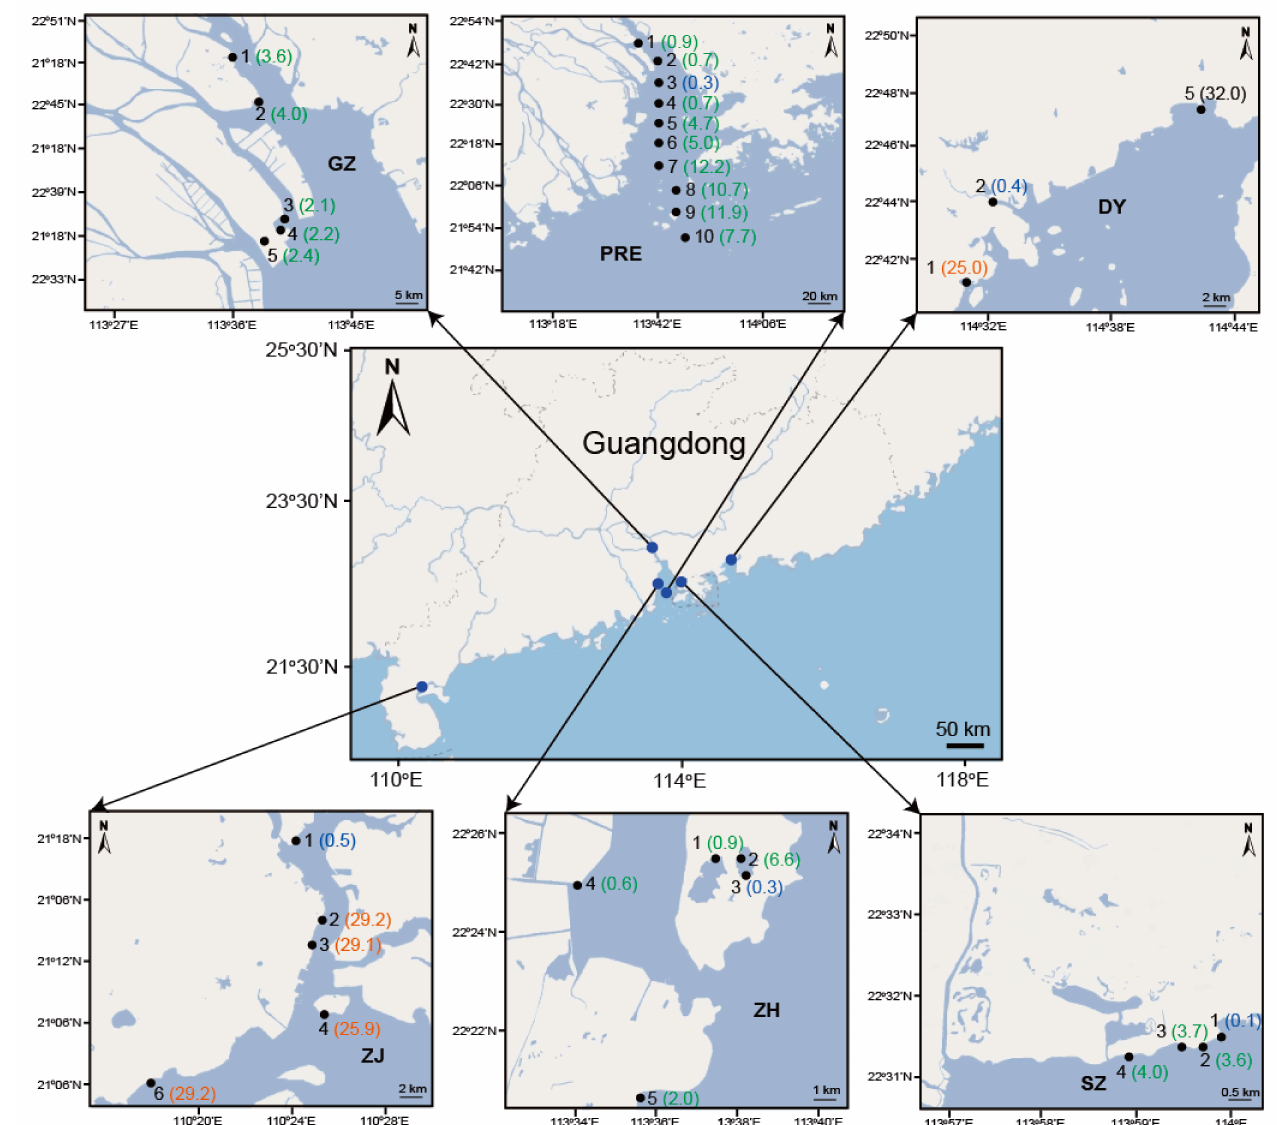
Figure 1. The location of sampling regions. Sampling areas and their abbreviations are as follows: Daya Bay (DY1, DY2, DY5), Pearl River Estuary (PRE1–PRE10), Guangzhou (GZ1–GZ5), Shenzhen (SZ1–SZ4), Zhuhai (ZH1–ZH5), and Zhanjiang (ZJ1–ZJ4, ZJ6). The numbers shown in parentheses represent the salinity of the sampling sites (unit: ‰), and salinity values of freshwater, low-brackish, high-brackish, and marine areas are colored in blue, green, orange, and black, respectively. Adapted with permission from [34] published by John Wiley and Sons,